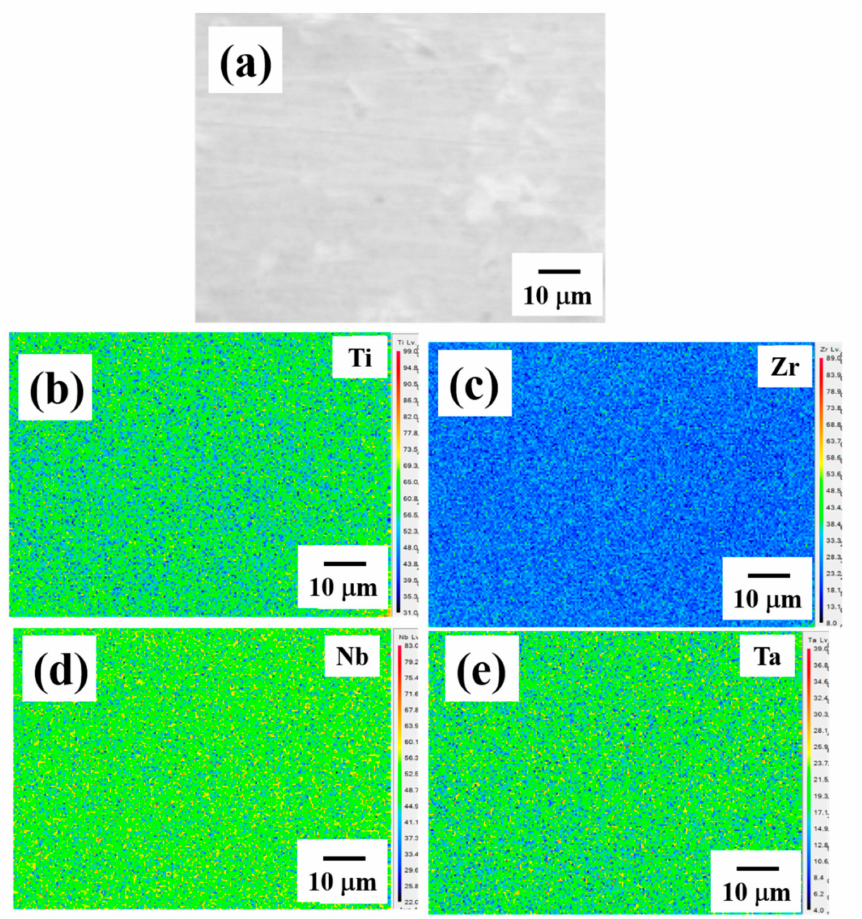
Figure 3. ( a ) The SEM BEI of the as-homogenized Ti 25 Zr 25 Nb 25 Ta 25 HEA, and the corresponding composition mapping for ( b ) Ti, ( c ) Zr, ( d ) Nb, and ( e )